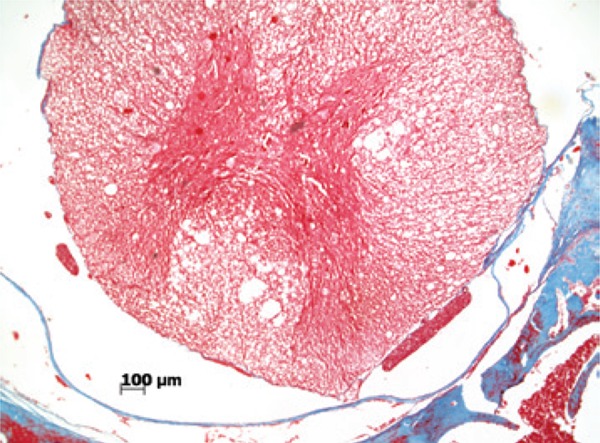
Fotomicrografia de um rato do Grupo Sutura Simples (tricromo de Masson, 40X). A medula espinal está no centro, em vermelho, envolta pela pia-máter e a dura-máter, corada em azul com aspecto preservado